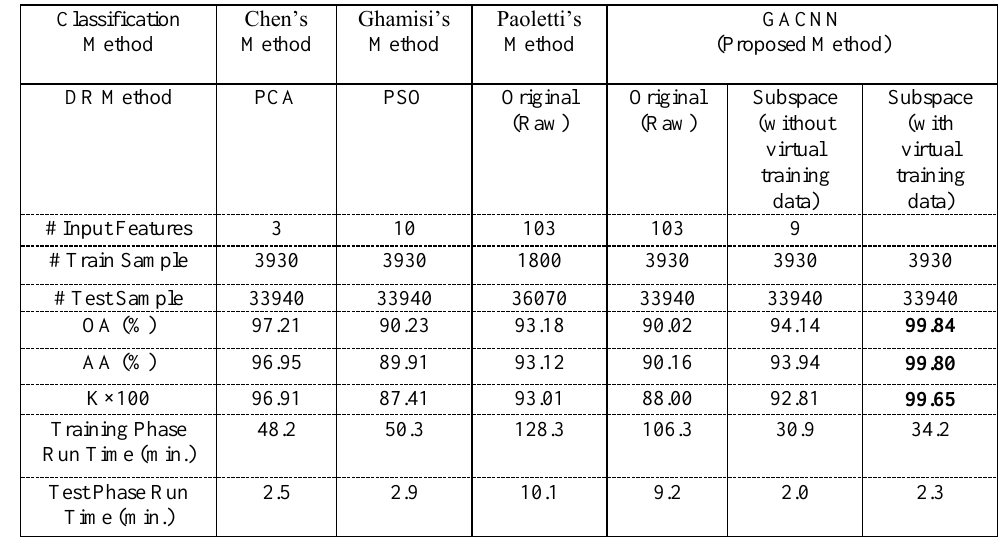
Table 3.Classification results on the University of Pavia dataset